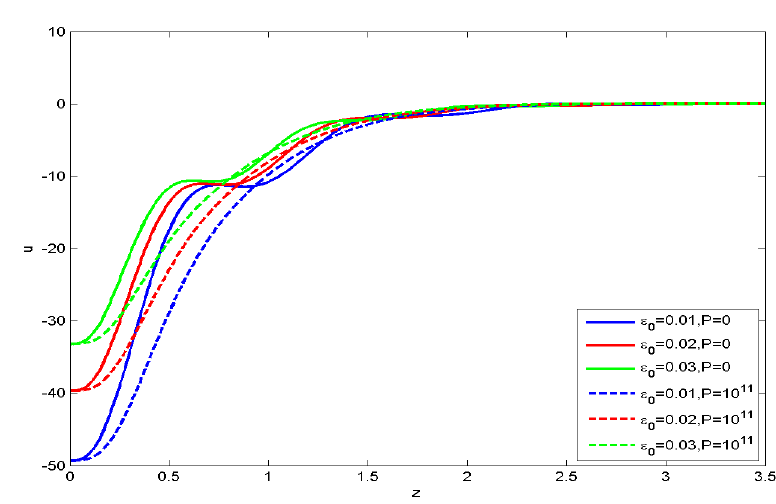
Figure 10. Horizontal displacement u concerning z with electric field ε 0